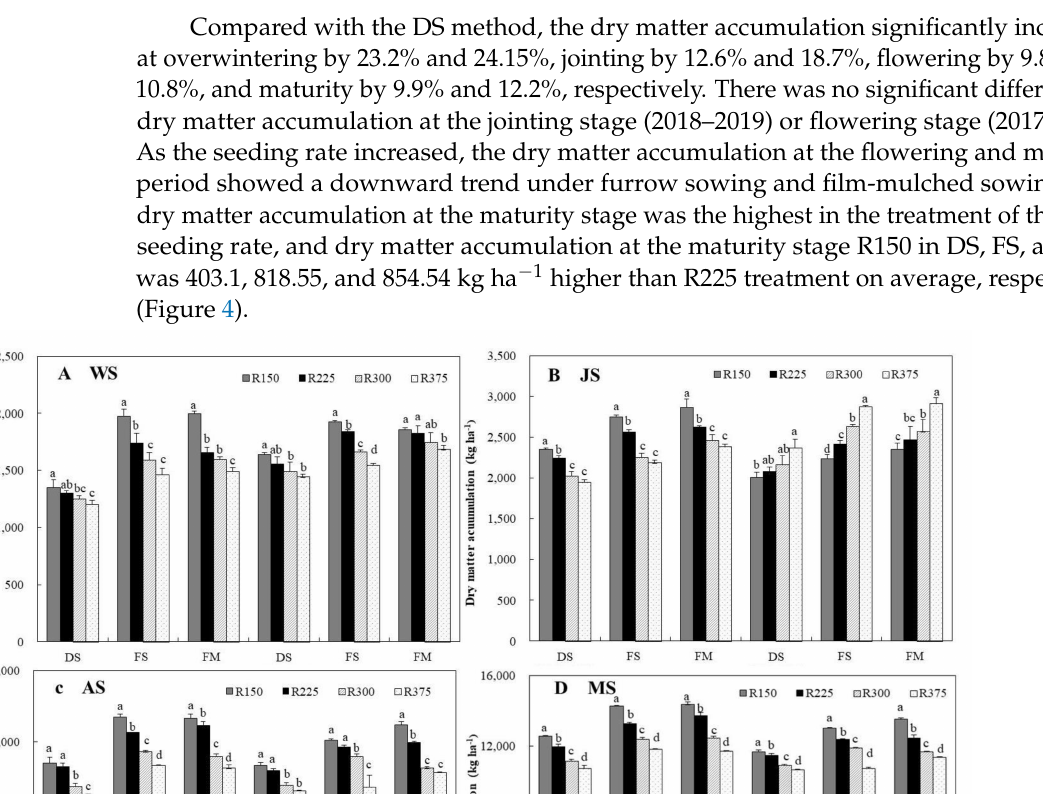
* and ** indicate significance at p ≤ 0.05 and p ≤ 0.01, respectively.